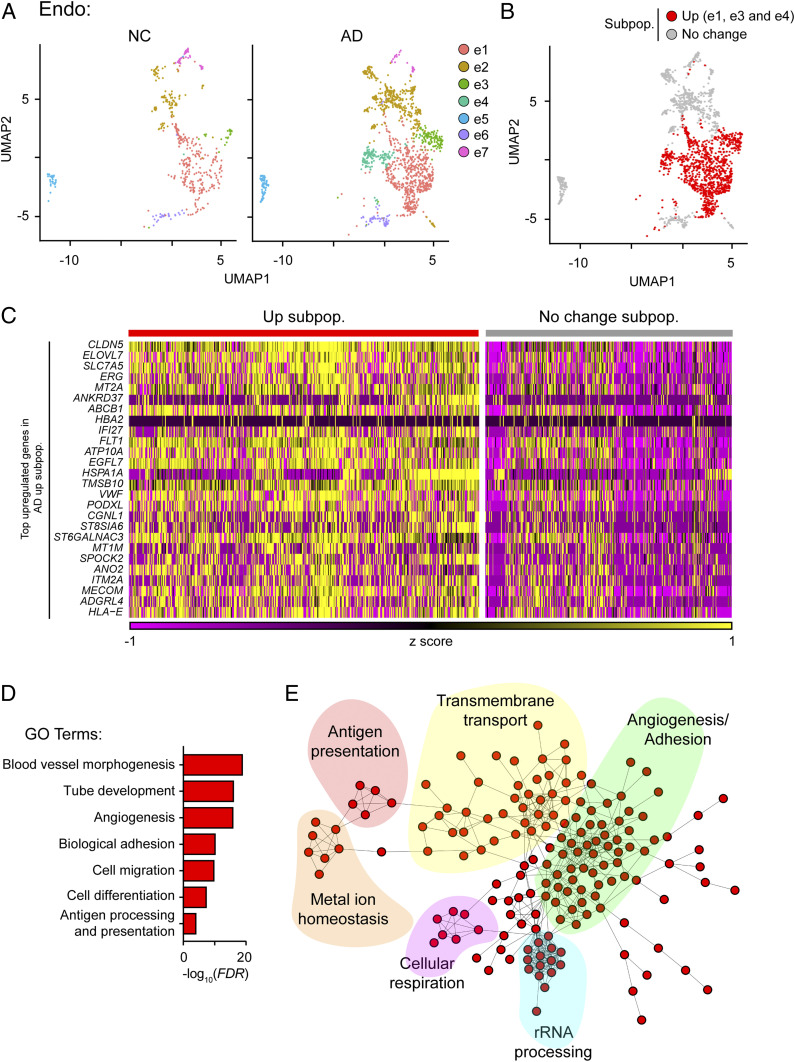
An endothelial cell subpopulation associated with enhanced angiogenesis and antigen presentation is increased in AD. (A–C) Transcriptomically unique subpopulations of endothelial cells were present in AD samples. (A) UMAP plots showing the distributions of endothelial subpopulations (e1–e7) in AD and NC prefrontal cortical samples. (B) Distribution of AD-associated endothelial subpopulations. Red: AD-up-regulated subpopulations (i.e., e1, e3, and e4). (C) Expression levels of the top enriched genes in the AD-up-regulated subpopulations at the single-cell level (adjusted P < 0.1, log2 fold change ≥ 0.1). Up subpop.: up-regulated subpopulation. (D and E) The activated endothelial cells in AD were associated with angiogenesis and antigen presentation. GO analysis of the up-regulated genes in AD-up-regulated endothelial subpopulations (D), and STRING analysis (E) showing that the signature genes of activated endothelial cells form a protein–protein interaction network associated with six different functional pathways. See also SI Appendix, Fig. S7 and Table S5.